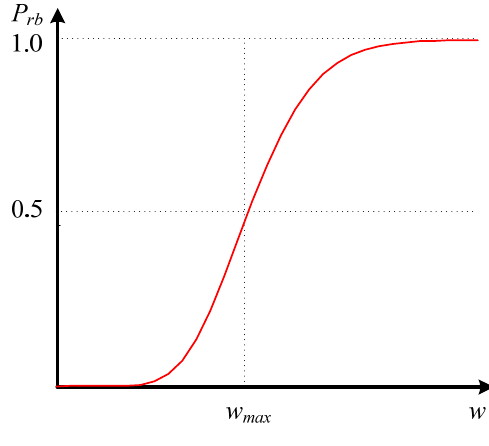
Figure 9. Refuse-operation probability for bit error.